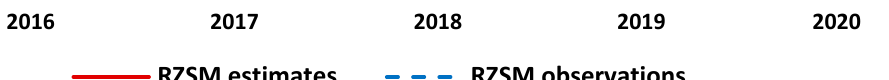
Figure 3. Time series of root-zone soil moisture (cm 3 · cm − 3 ) from 2016 to 2020 at the ( a ) Shebotu site, ( b ) Huolinguole site and ( c ) Wengniute site. Red solid lines indicate root-zone soil moisture measurements at in-situ stations, and blue dotted lines indicate root-zone soil moisture predictions from the calibrated SMAR model at the point scale, where the ESA CCI near-surface soil moisture data are used for model forcing.